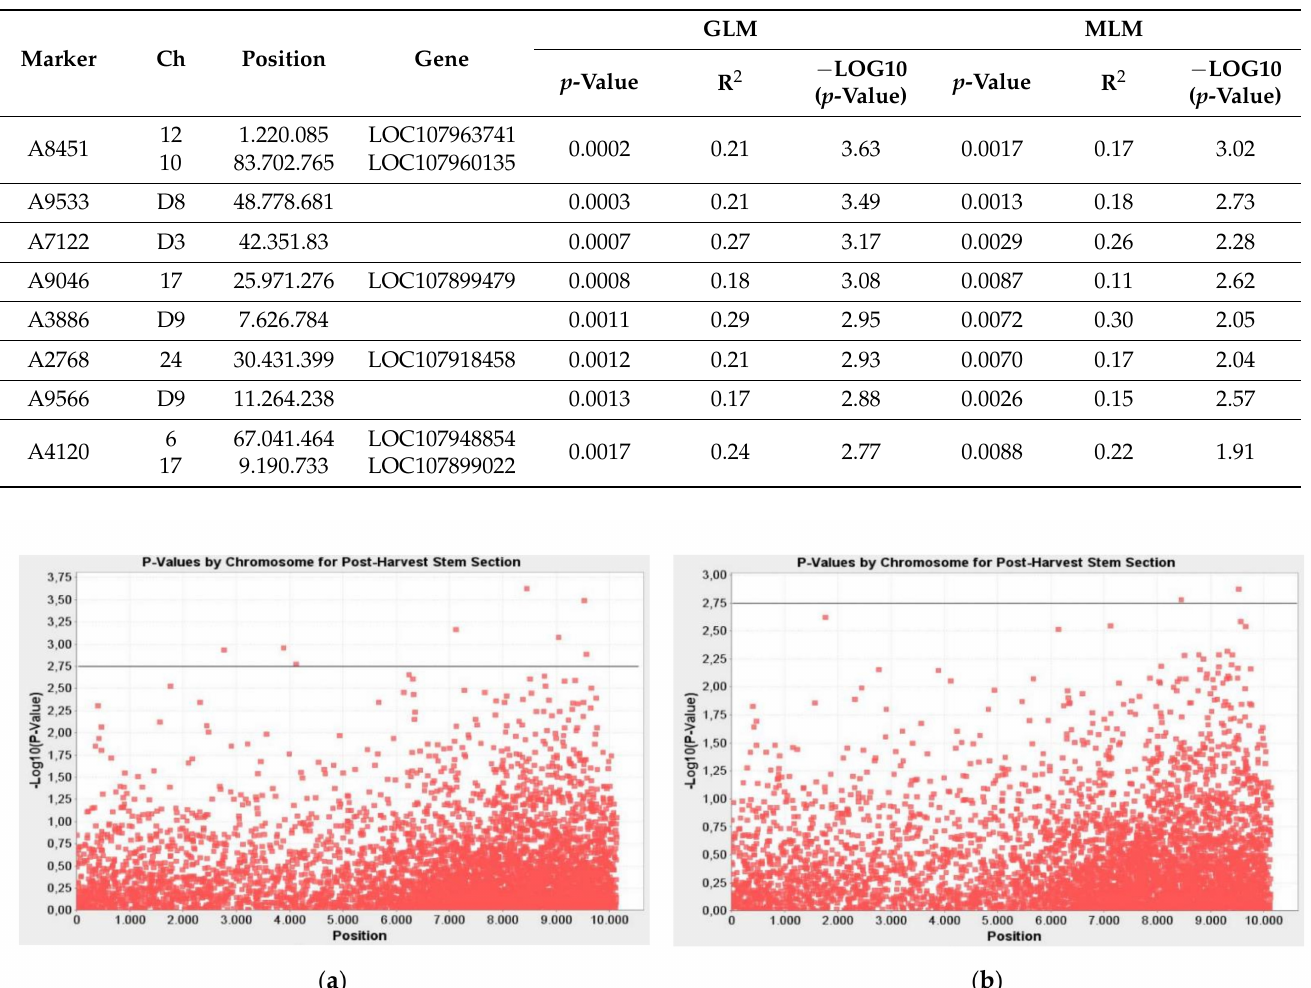
Table 2. Post-harvest stem section and markers associated with Verticillium wilt disease resistance/tolerance.